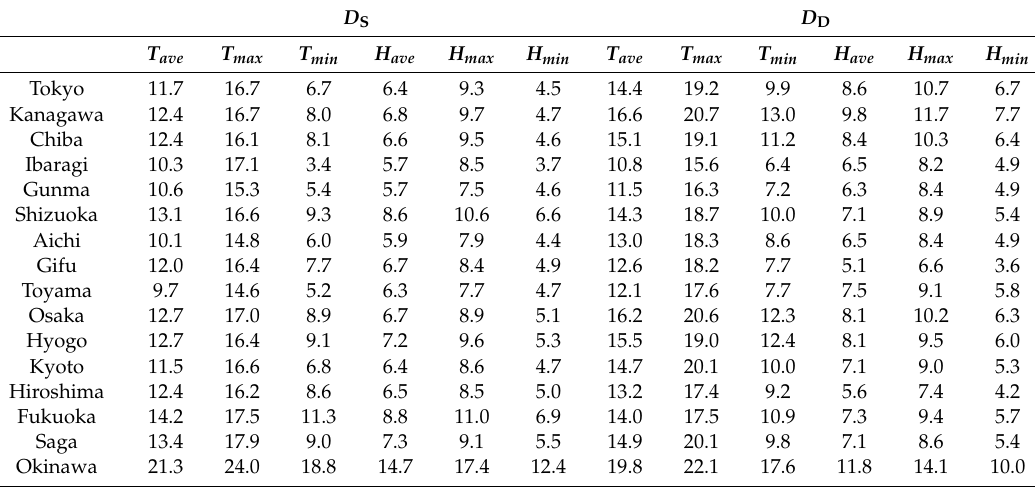
Table 3. Daily average, maximum and minimum temperature, and absolute humidity values. The values are averaged during the spread and decay stages as listed in Table 2. T ave , T max , and T min represent the daily average, maximum, and minimum temperatures, respectively. H ave , H max , and H min represent the daily average, maximum, and minimum absolute humidity values, respectively.